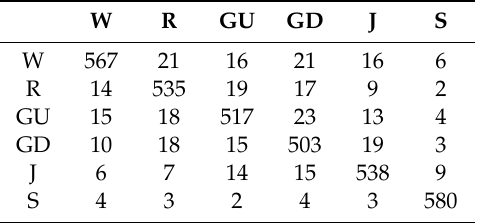
Table 9. Confusion matrix for DMGSOSEN-based HAR on the data from the left ankle when the initial pool size is 100.